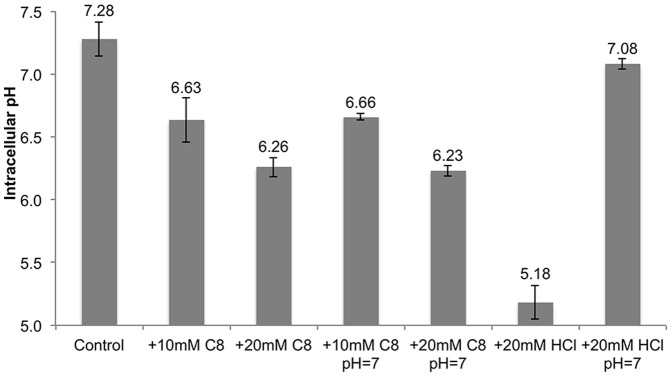
Octanoic acid challenge decreases the intracellular pH.E. coli MG1655 pJTD1 was grown to midlog in minimal media at pH(HCl). Values are the average of 4 biological replicates, with error bars indicating the standard deviation.